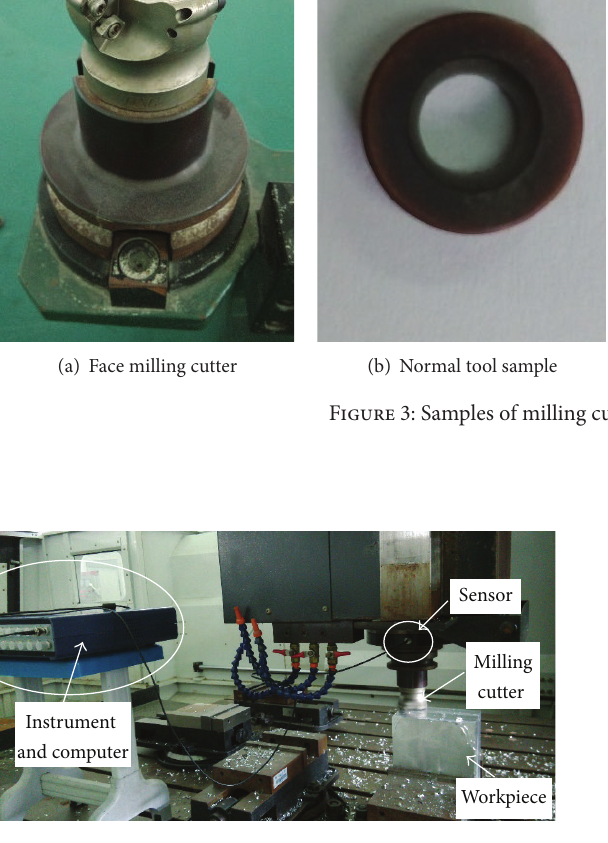
Figure 4: Experiment illustration.